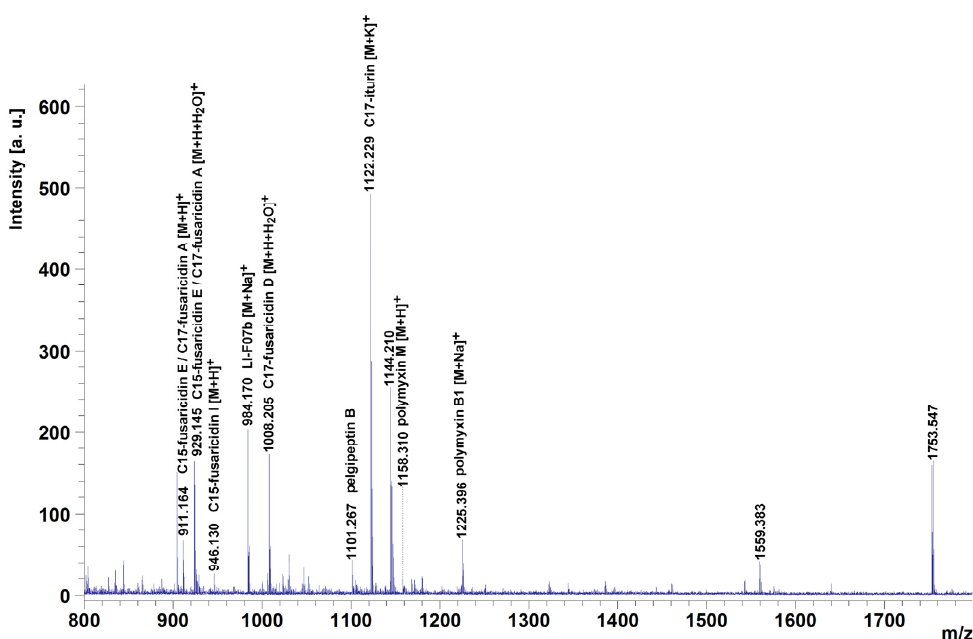
Figure 4. MALDI-TOF mass spectrum of cell-free culture supernatant of Paenibacillus polymyxa ShX301 in the range of m/z 800 ‒ 1800.